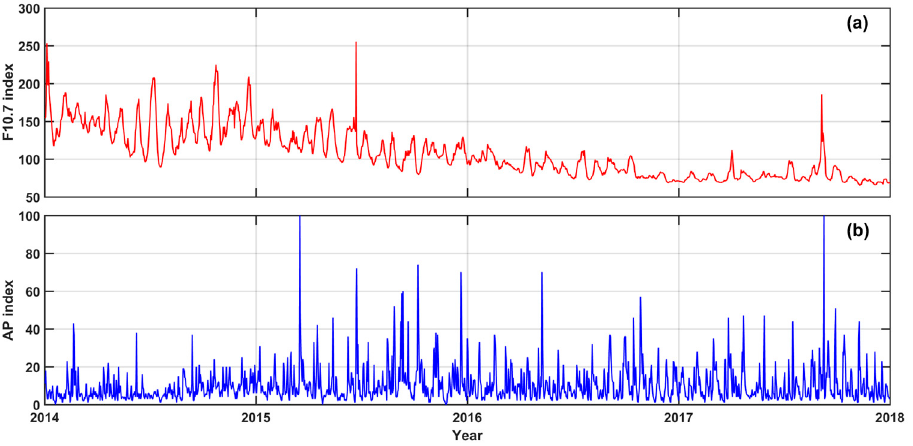
Figure 1. Variations of daily F10.7 index ( a ) red line and Ap (the equivalent planetary daily amplitude) index ( b ) blue line during the year from 2014 to 2017.